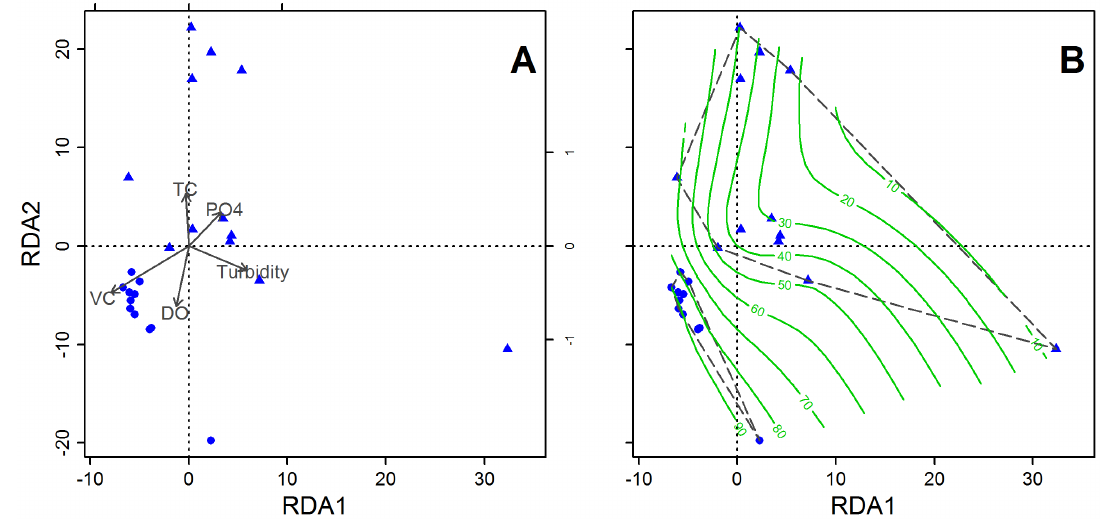
Figure 3. Redundancy Analysis (RDA) of macroinvertebrate community assemblages from catchments with different vegetation covers (VC). This ordination analysis detected two groups of macroinvertebrate assemblages: solid circles represent macroinvertebrate communities in catchments with 70–95% in VC and triangles indicate macroinvertebrate communities in catchments with less than 70% in VC. Each symbol represents the community of a single catchment, i.e. macroinvertebrate community at catchment SF3. A Shows the RDA ordination with vector fitting of five variables selected during analysis. DO= dissolved oxygen, TC= total coliforms, PO 4 = phosphate. B Displays in green curves the fitted surface only for the percentage of VC, which is the most explicative variable of the ordination (65%). Dashed lines enclose and separate the detected groups.